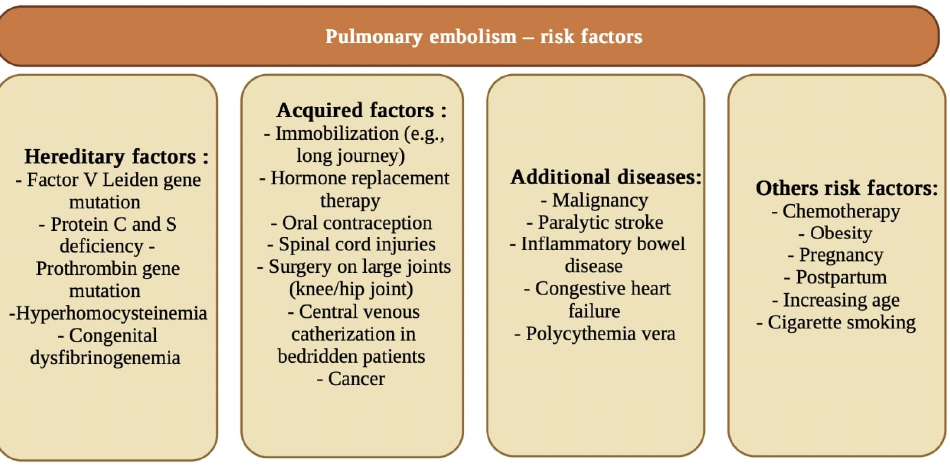
Figure 3. Risk factors predisposing to pulmonary embolism